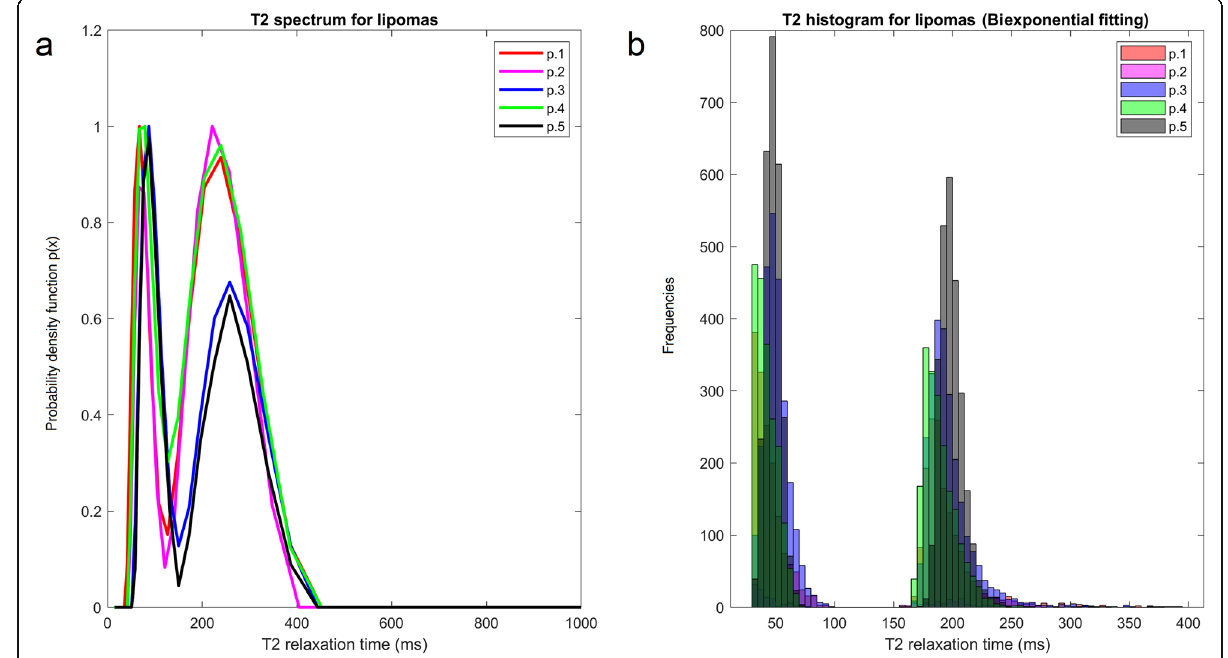
Fig. 5 Per-patient analysis of T2 relaxometry data with inverse Laplace method ( a ) and Mexp method ( b ) for five lipoma patients